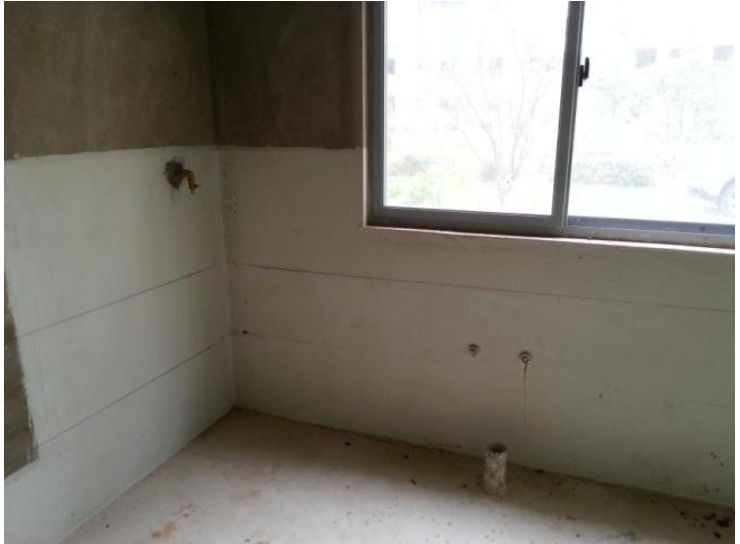
Figure 7. A room in a basic apartment with no systems, appliances or